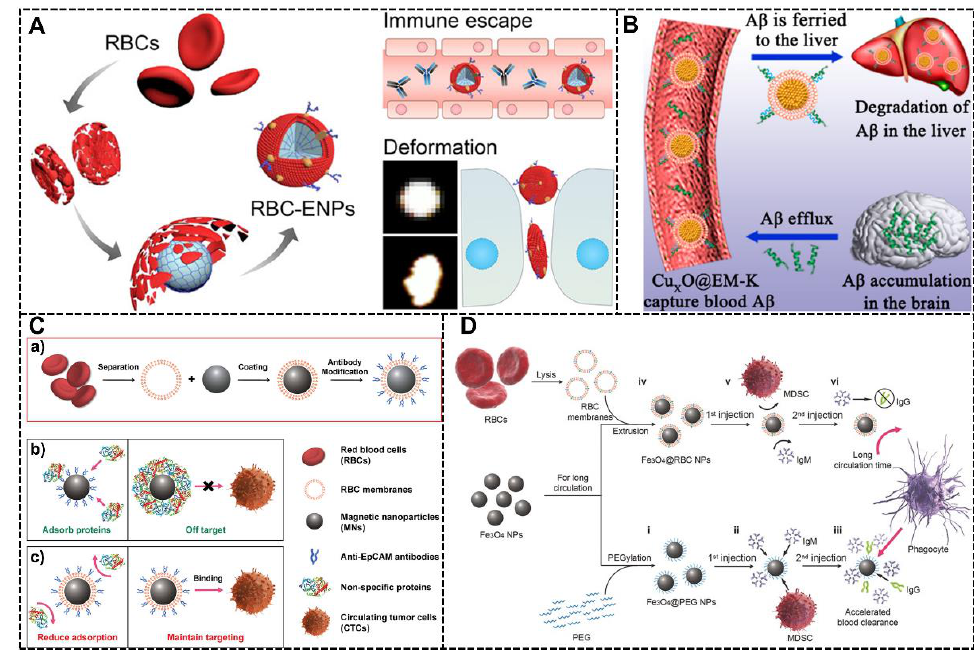
Figure 4. RBC membrane decoration to harness protein corona. ( A ) The RBC-mimic system (RBC-ENPs) was constructed based on the RBC membrane and poly (ethylene glycol) diacrylate (PEGDA) NPs. The RBC cell membrane decoration endowed this system with the ability of immune escape by controlling the composition of the protein corona and deformation for better tumor penetration [50]. Copyright 2022, American Chemical Society. ( B ) A biomimetic system with RBC membrane decoration (CuxO@EM-K). The RBC membrane would impede the formation of the protein corona and minimize immunogenicity, facilitating the ability to adsorb A β efficiently for a much longer time [68]. Copyright 2020, American Chemical Society. ( C ) The preparation and mechanism of RBC-IMNs system for enhanced isolation of CTCs. (a) The RBC membrane was decorated onto the IMSs before antibody modification; (b) The IMNs without the RBC decoration will absorb proteins in biological fluids, and the protein corona will largely influence the isolation efficiency and cause the off-target effect; (c) The IMNs with RBC membrane decoration will reduce the formation of the protein corona, and therefore maintain the targeting ability of IMNs for CTCs isolation in biological fluids [67]. Copyright 2019, American Chemical Society. ( D ) The RBC membrane decoration is an ideal superior alternative to PEG for prolonged circulation time and escapes from clearance by the immune system [66]. Copyright 2015